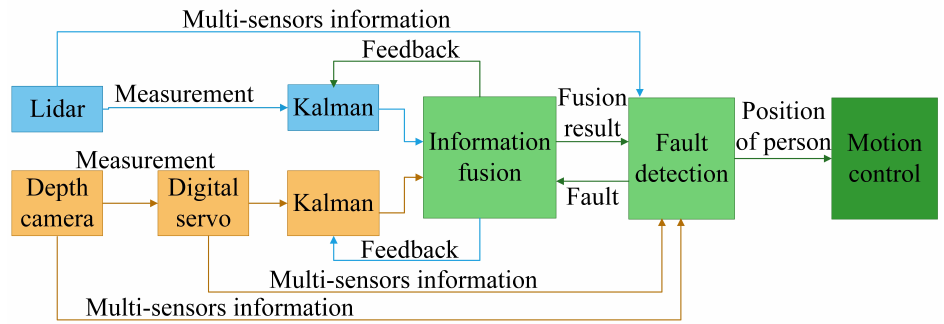
Figure 1. Adaptive federated filter framework, including information update, information fusion, information sharing factors, feedback resetting, fault detection and